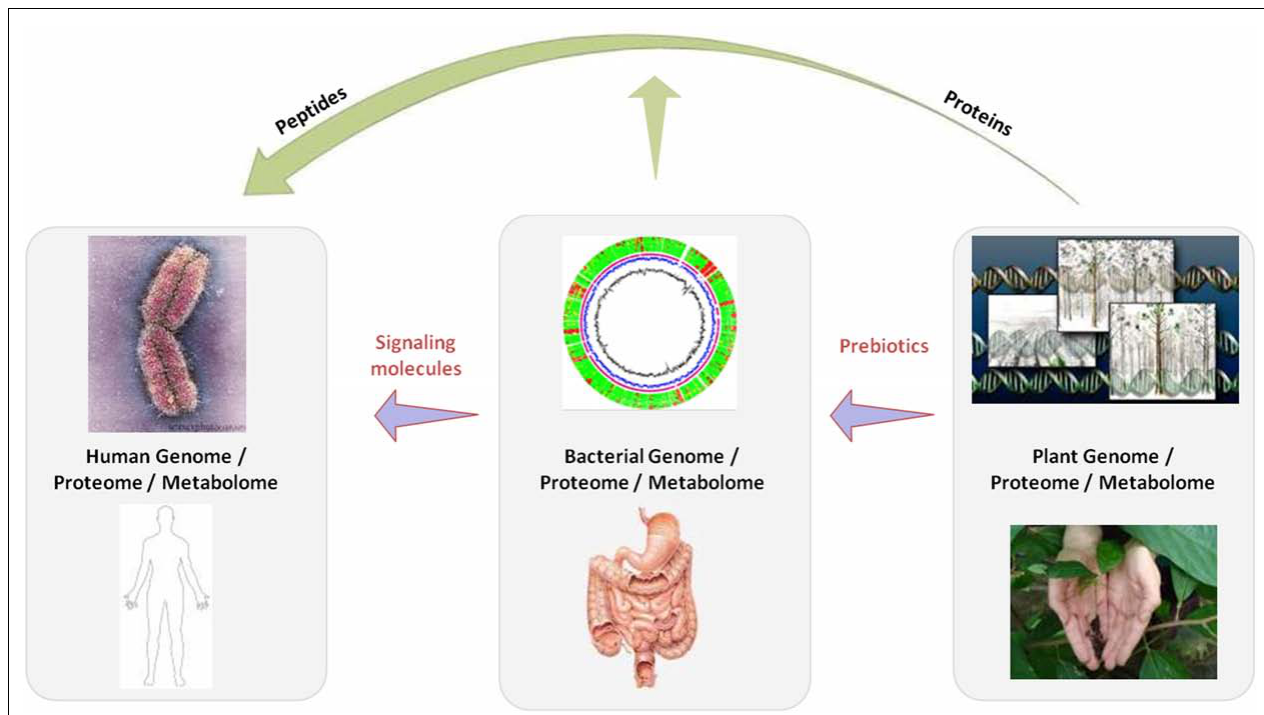
FIGURE 1 | Extended nutrigenomics for nutrition and health: the plant genome for example affects the human genome either through direct impact of its bioactives (incl. proteins and peptides), or indirectly via the gut microbial metabolism providing nutrients on which specific gut bacteria can feed.